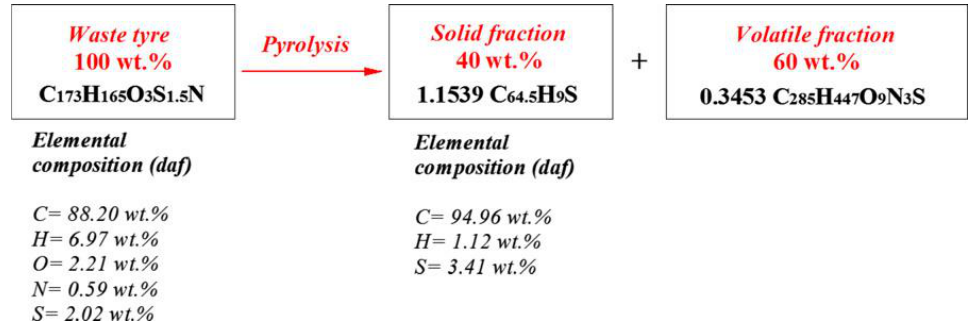
Figure 6. Elemental analysis of tire pyrolysis process ( daf means dry ash-free basis) [6] (adapted with permission from Elsevier).